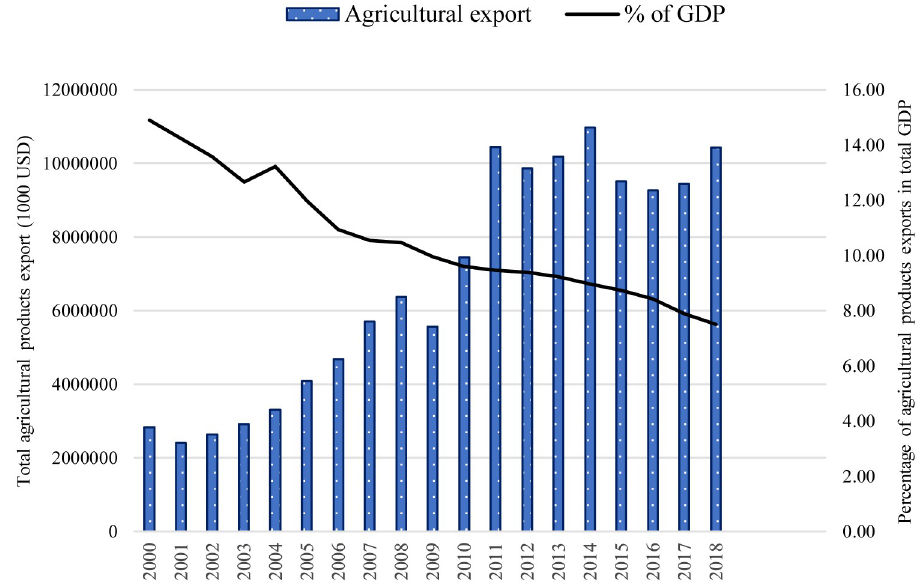
Fig 1. Agricultural commodities export trend 2000–2018.